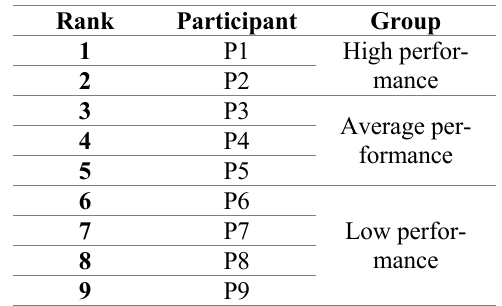
Categorization of candidates into three performance groups for psychological selection test.